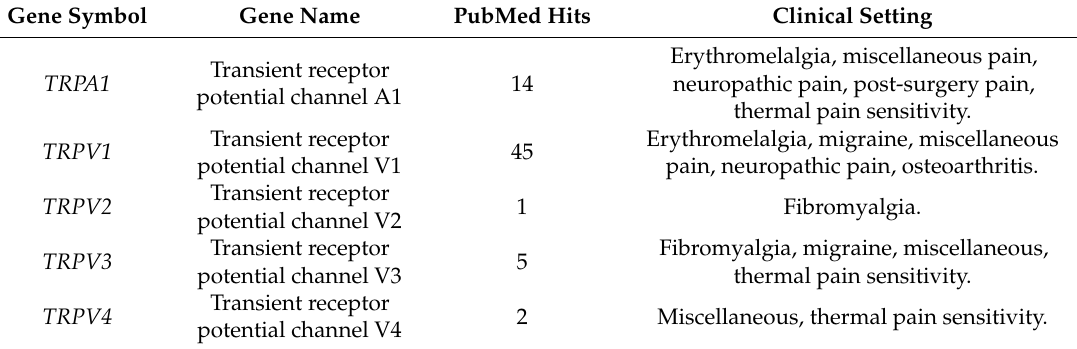
Figure 5. Display of the number of variants in the genes selected as candidates for the present association analysis. ( A ) Bar plot of the number of variants per gene included in the analysis. The full set (“d_full”, green bars) refers to the original set of genetic variants observed by means of the next-generation sequencing of the selected genes. The final set (“d_final”, blue bars) comprises the most informative variants that remained after several steps of feature selection and machine-learned association of the NGS-based genetic information with the machine learning-derived thermal pain-related phenotype. The number of variants per gene is also displayed numerically above the respective bar. The figure has been created using the R software package (v. 3.6.2 for Linux; http: // CRAN.R-project.org / [25]) and the R package “ggplot2” (https: // cran.r-project.org / package = ggplot2 [26]). Table 3. PubMed search results about previous evidence of a functional role of selected genetic